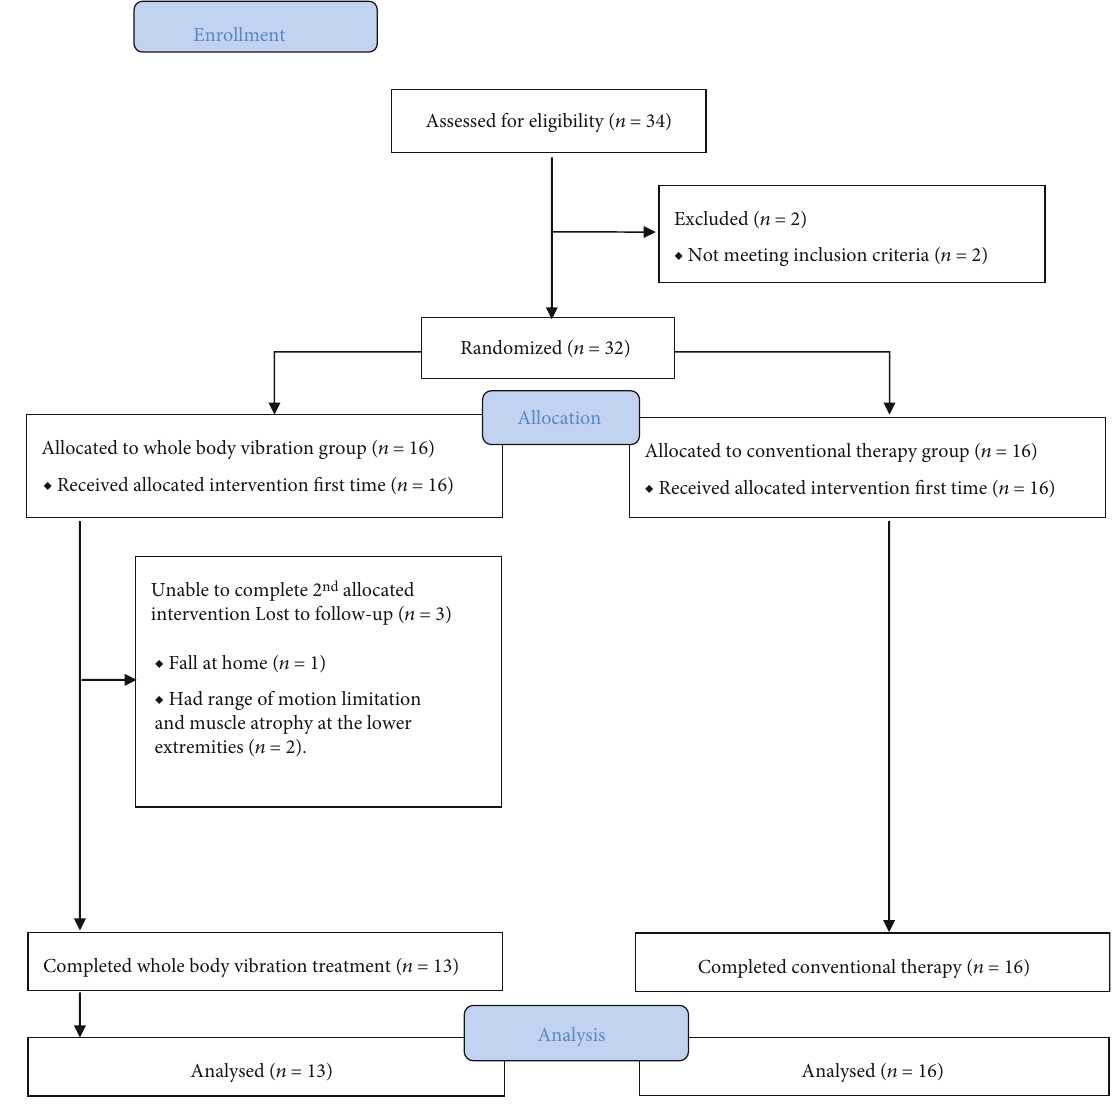
Figure 2: CONSORT fl ow diagram. Table 1: Demographic characteristics of the